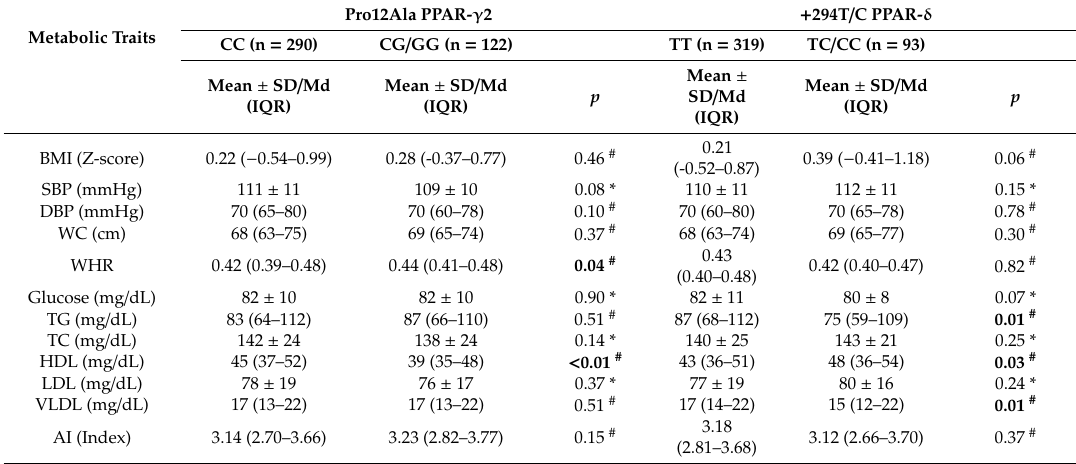
Table 5. Metabolic traits comparison between Pro12Ala PPAR- γ 2 and + 294T / C PPAR- δ genotype (major allele homozygous vs. minor allele carriers) in the total studied